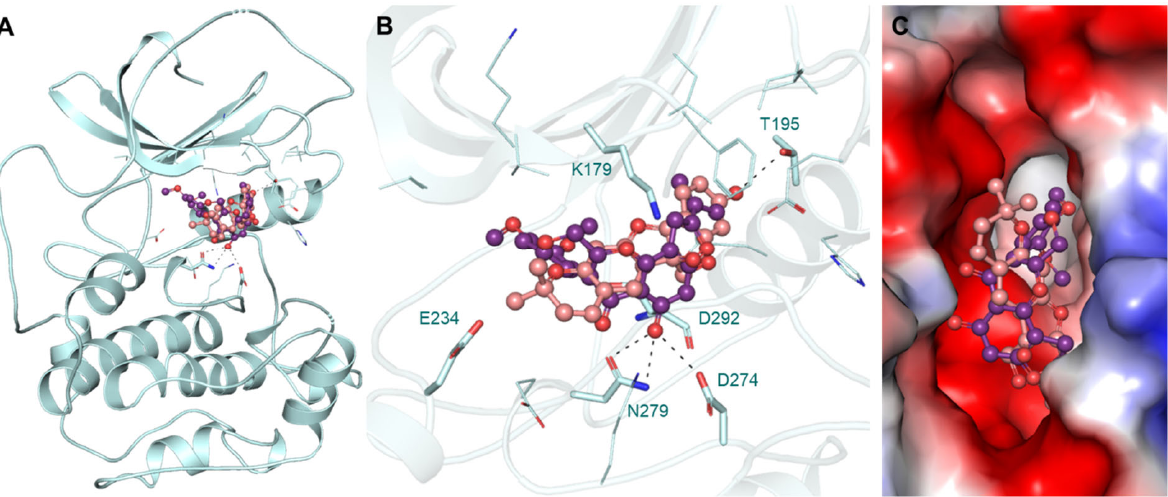
Figure 1. The schematic representation of the structure of AKT1 in a bound state with tuberosin and villosol. ( A ) Cartoon illustration of AKT1 with the elucidated molecules. ( B ) The representation of close interaction between AKT1 with tuberosin (red salmon) and villosol (purple). ( C ) The magnified illustra ‐ tion shows the surface potential view of the binding pocket of AKT1 with elucidated compounds. The data from the interaction analysis is taken further for a detailed study against the target protein. The elaborate studies in the interaction unveil different types of noncovalent interactions that are formed between AKT1 and tuberosin or villosol. The two ‐ dimensional plots of the probable interactions were obtained for both the compounds using Discovery Stu ‐ dio Visualizer. Both compounds interact with the Lys179 and Asp 274 residues on the ATP binding site and active site, respectively (Figure 2). Both compounds share common features of binding and, thus, can act as ATP ‐ competitive inhibitors of AKT1. The selected confor ‐ mations of both compounds were taken for all ‐ atom MD simulations for 100 ns.